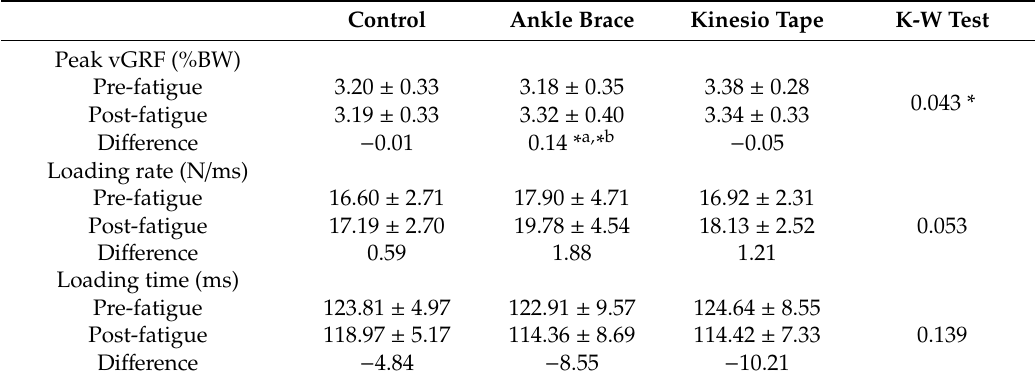
Table 2. Kruskal–Wallis and post hoc test results for fatigue-induced change in median values of the kinetic variables in single-leg lateral drop landing tasks performed by three